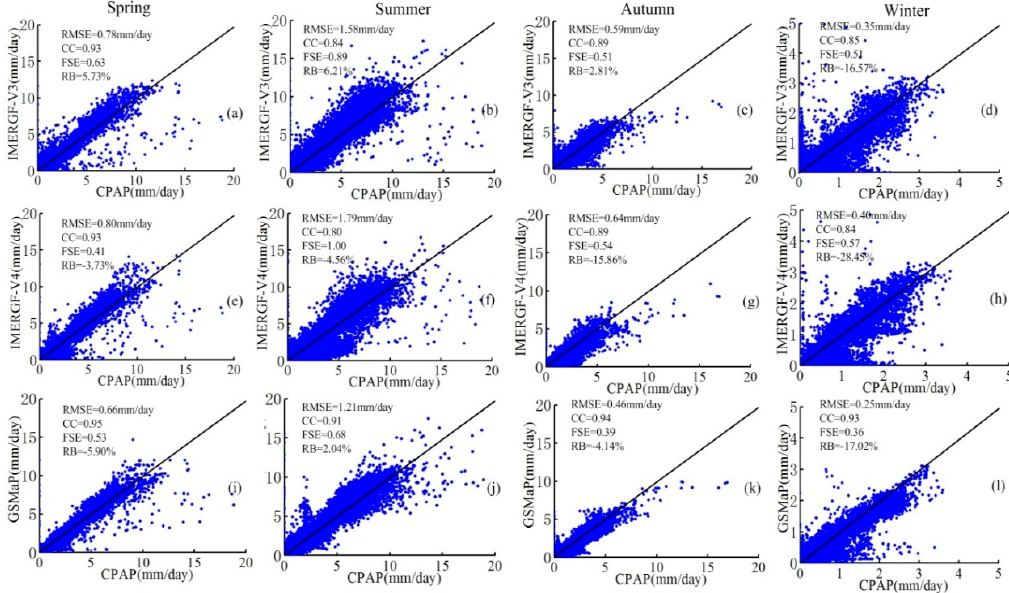
Figure 5. Scatterplots of seasonal daily average precipitation for the IMERGF-V3, IMERGF-V4, and GSMaP products versus CPAP from March 2014 to February 2015 ( a – l ).